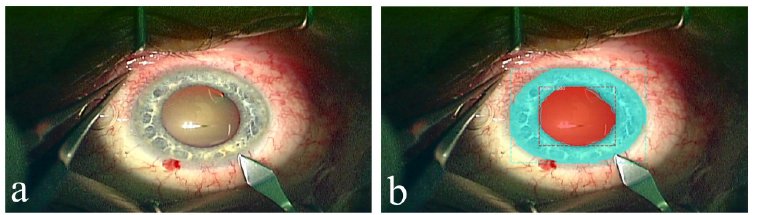
Fig 2. Original (A) and automatically segmented (B) frames from the Dataset B.